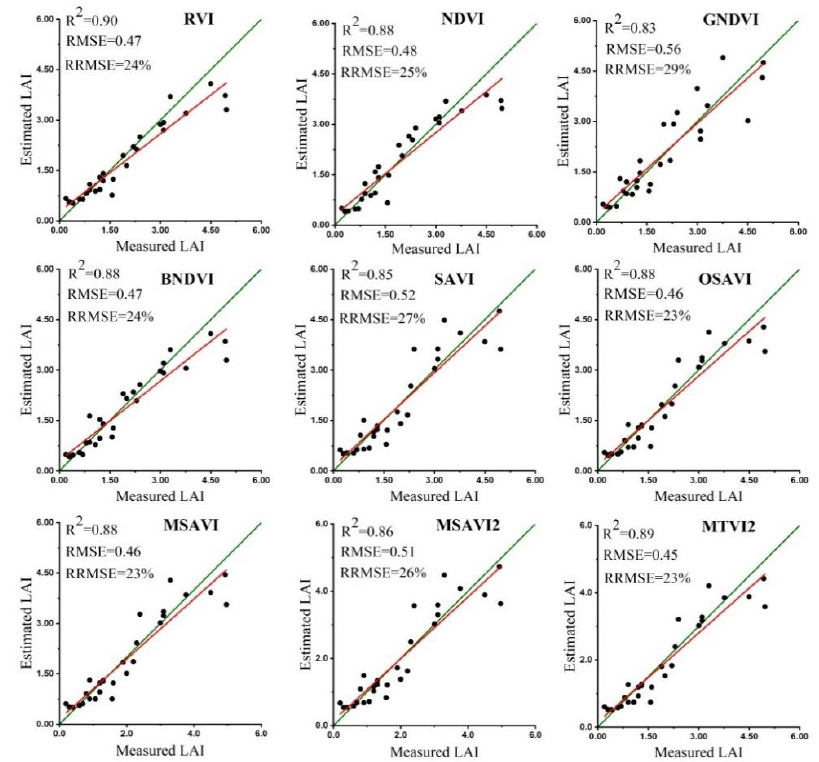
Figure 3. Estimated vs. measured LAI at the seedling stage. The green line shows the 1:1 correlation of the estimated and measured variables, whereas the red lines present the linear regression models.